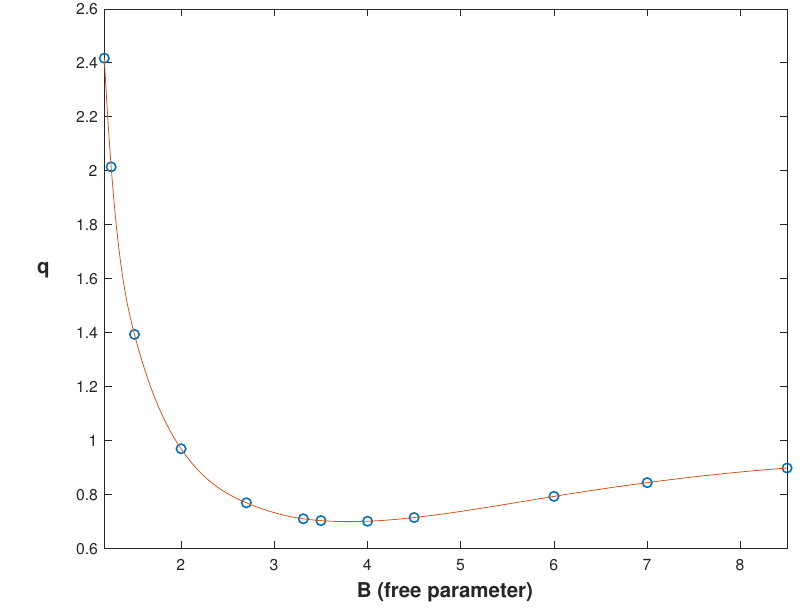
Figure 5. Electric charge q against the free parameter B